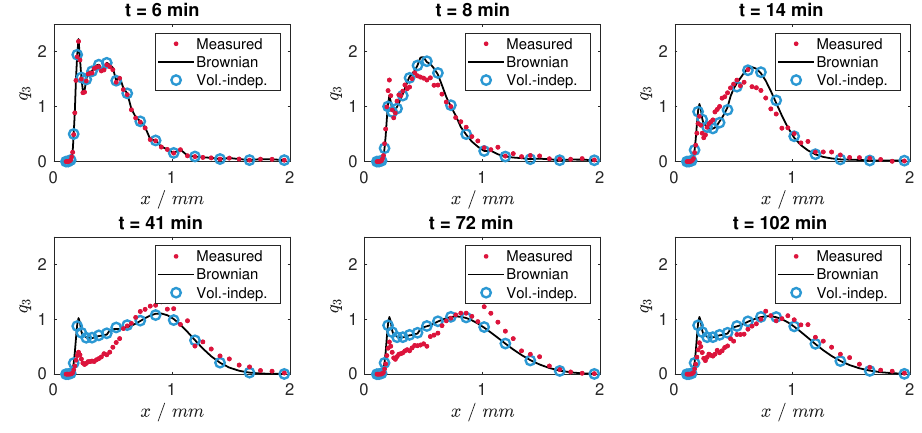
Figure 6. Particle size distributions q 3 of the actual plant and the identified models for the shifted time